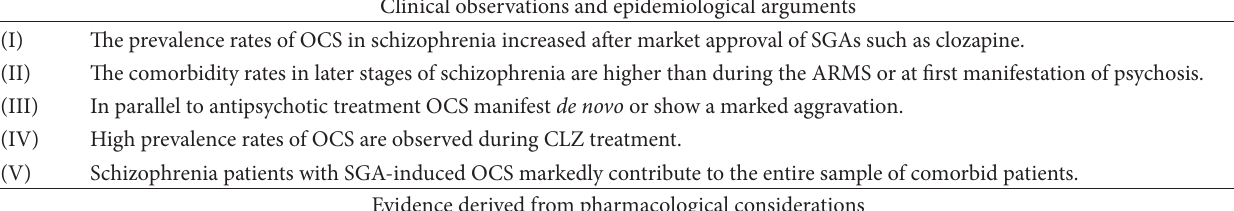
Table 1: SGAs induce or aggravate OCS. Clinical observations and epidemiological